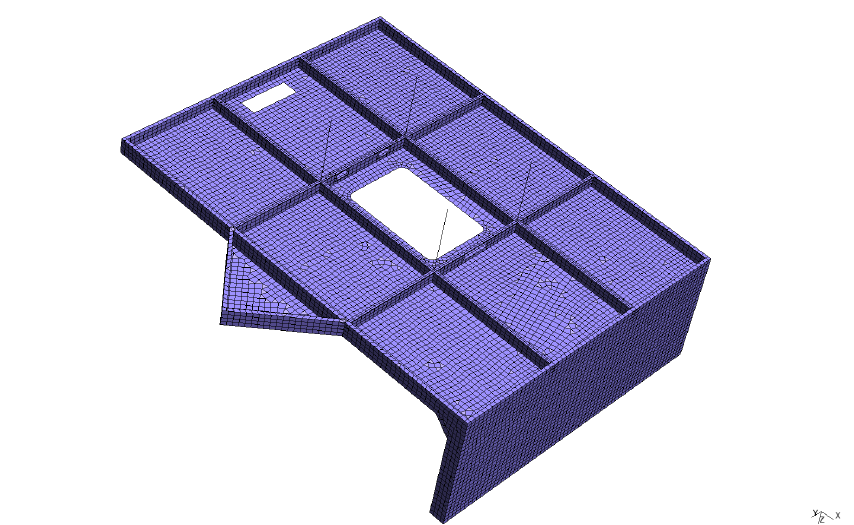
Figure 4. Meshing using the preconditioned gmsh algorithm Packing for Parallelograms from